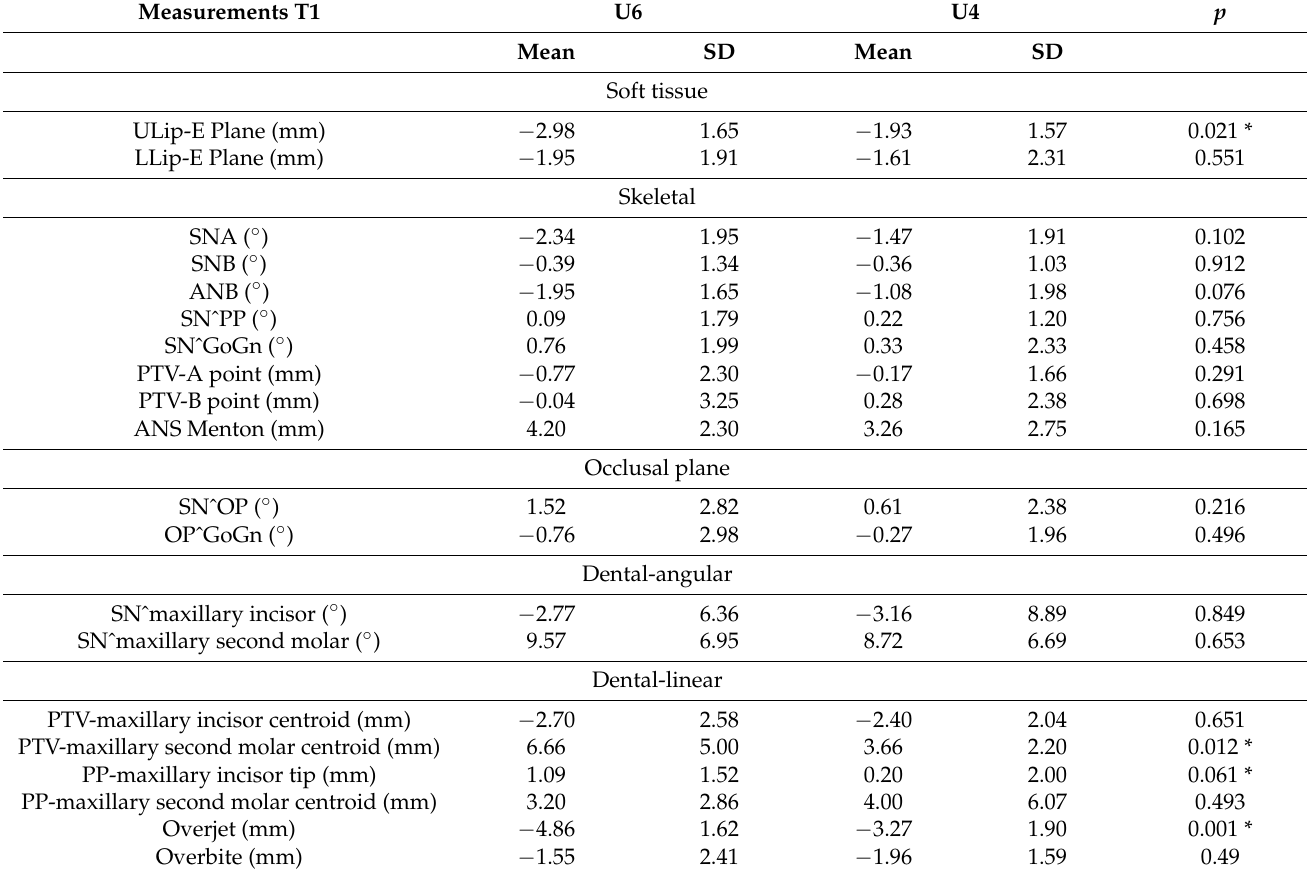
Table 4. Comparison of the increments between U6 and U4 group after treatment; * p <